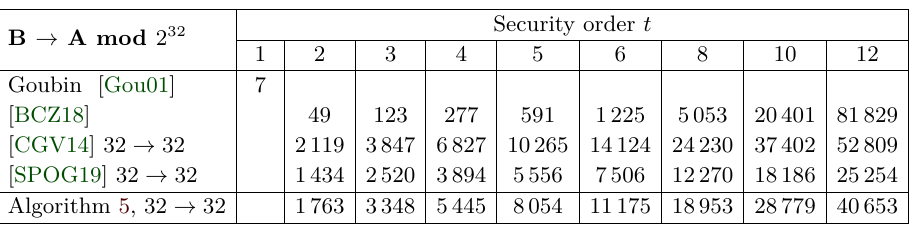
Table 2: Operation count for k -bit Boolean to arithmetic modulo 2 k conversion algorithms, up to security order t = 12, with n = t + 1 shares, for k = 32. Security order B → A mod 2 32